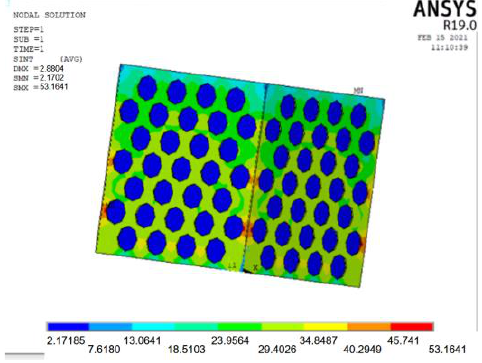
Figure 17. Stress diagram of perforated steel plate reinforced concrete model.